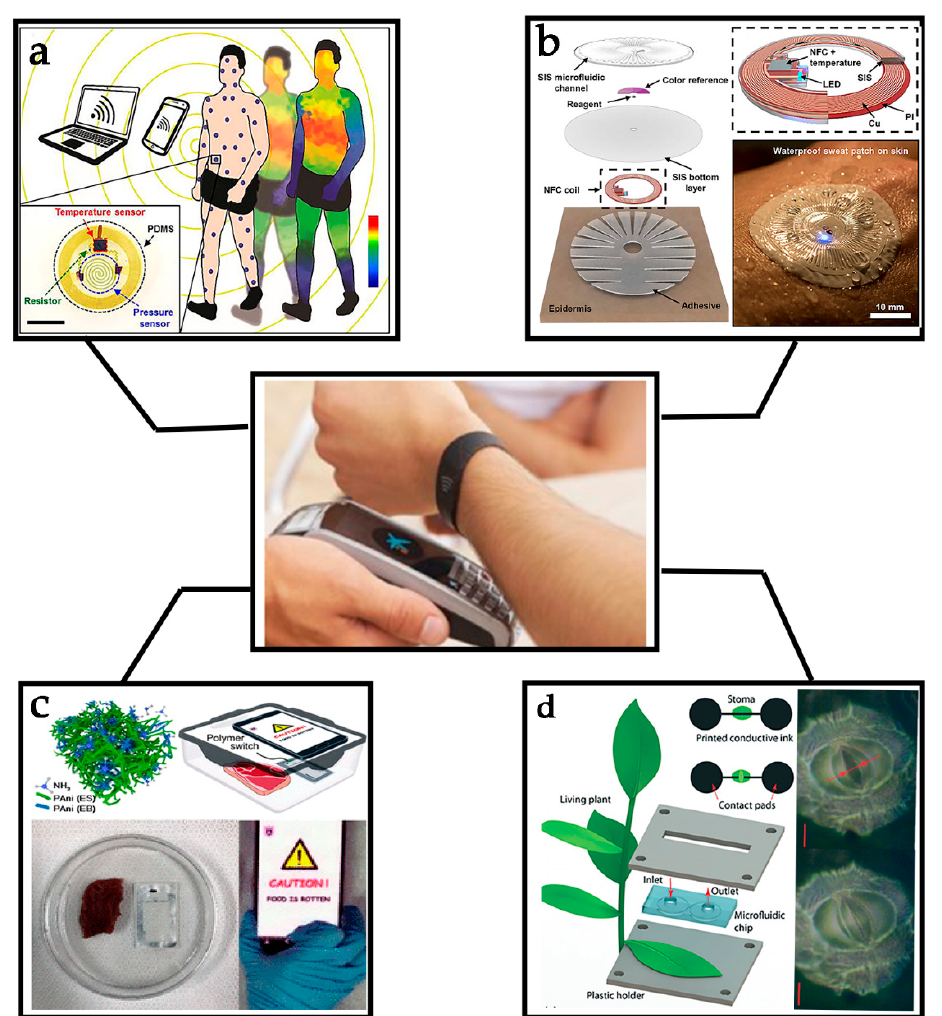
Figure 1. Recent progress in near-filed communication (NFC) sensors. ( a ) Biophysical signals monitoring. Reprinted with permission from ref. [21]. ( b ) Biochemical signals monitoring. Reprinted with permission from ref. [22]. ( c ) Food safety monitoring. Reprinted with permission from ref. [23]. ( d ) Plant growth monitoring. Reprinted with permission from ref.